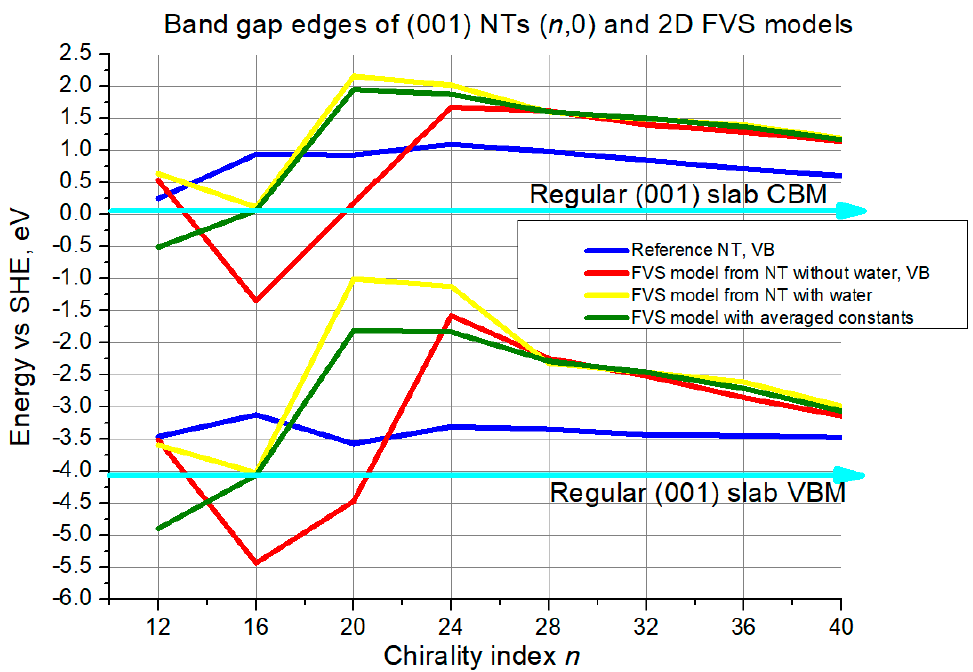
Figure 14. VB top and CB bottom edge positions for (001) NTs ( n ,0) and their 2D FVS models. The cyan lines with arrows denote slab limits for VB maximum and CB minimum.